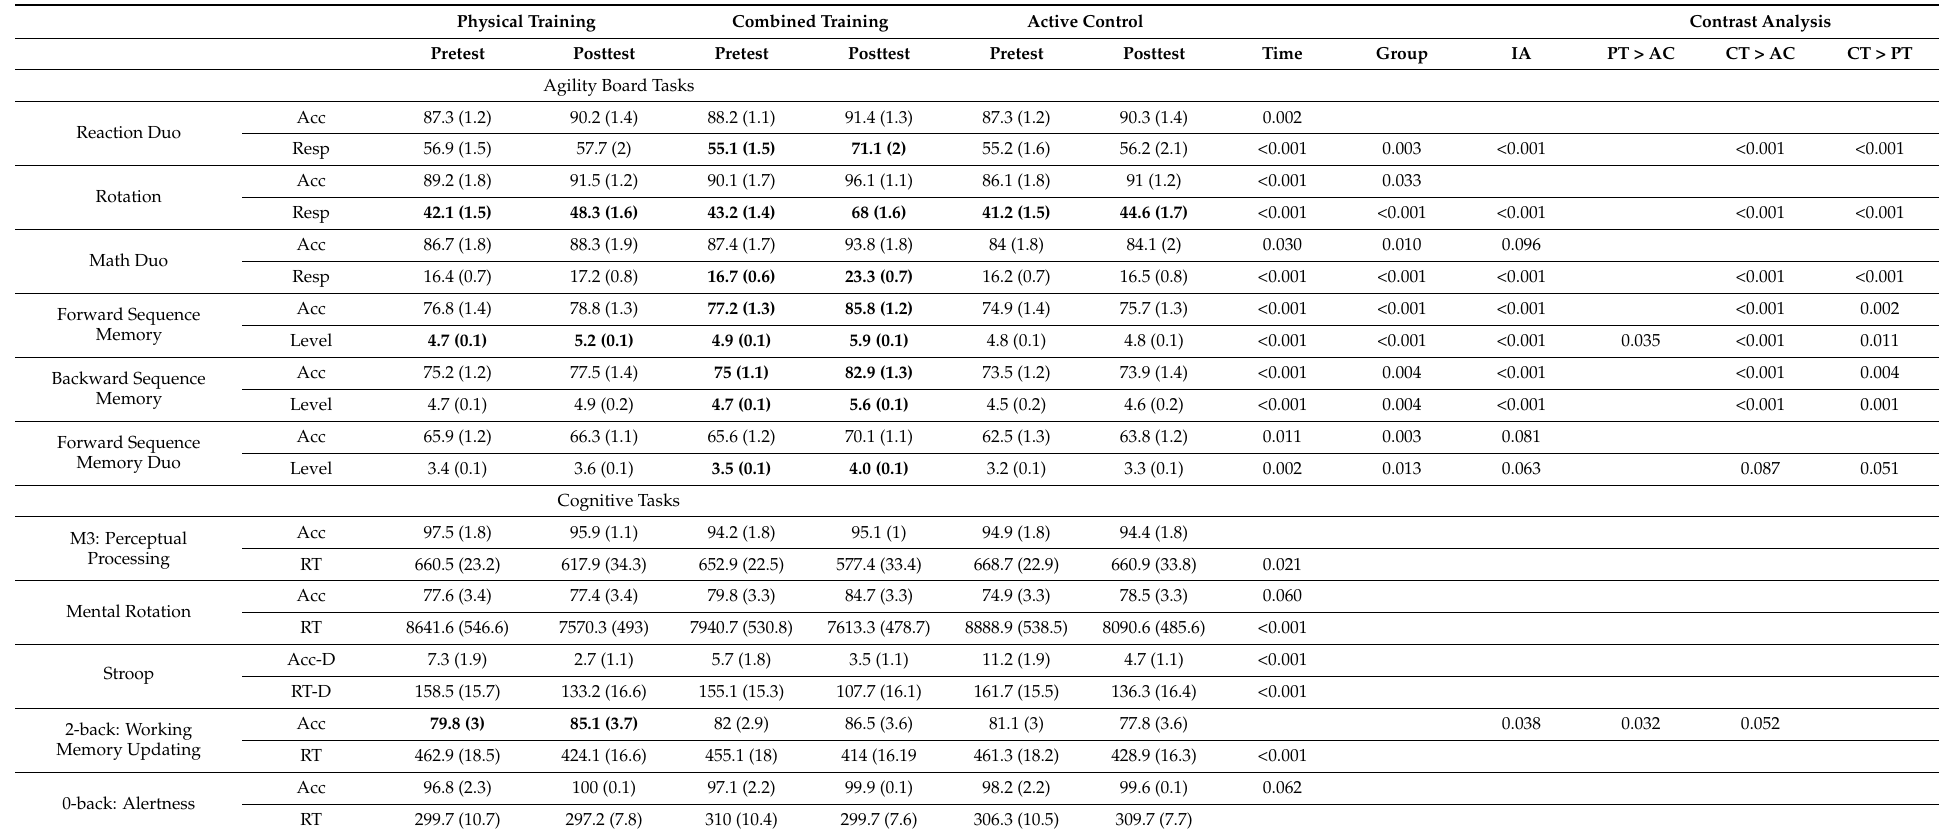
Table 3. Means (SD) of task performance at pretest and posttest as a function of group (physical training, combined training, or active control) for the Agility Board tasks and cognitive tasks, results of ANOVAs with the main effects of Time and Group and Time × Group interactions, and results of contrast analyses of the training gains of the three